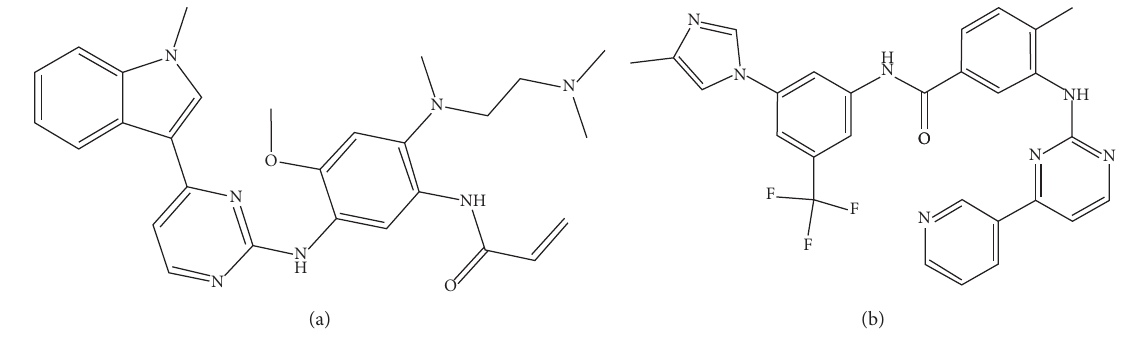
Figure 1: The chemical structures of osimertinib (a) and nilotinib (IS)